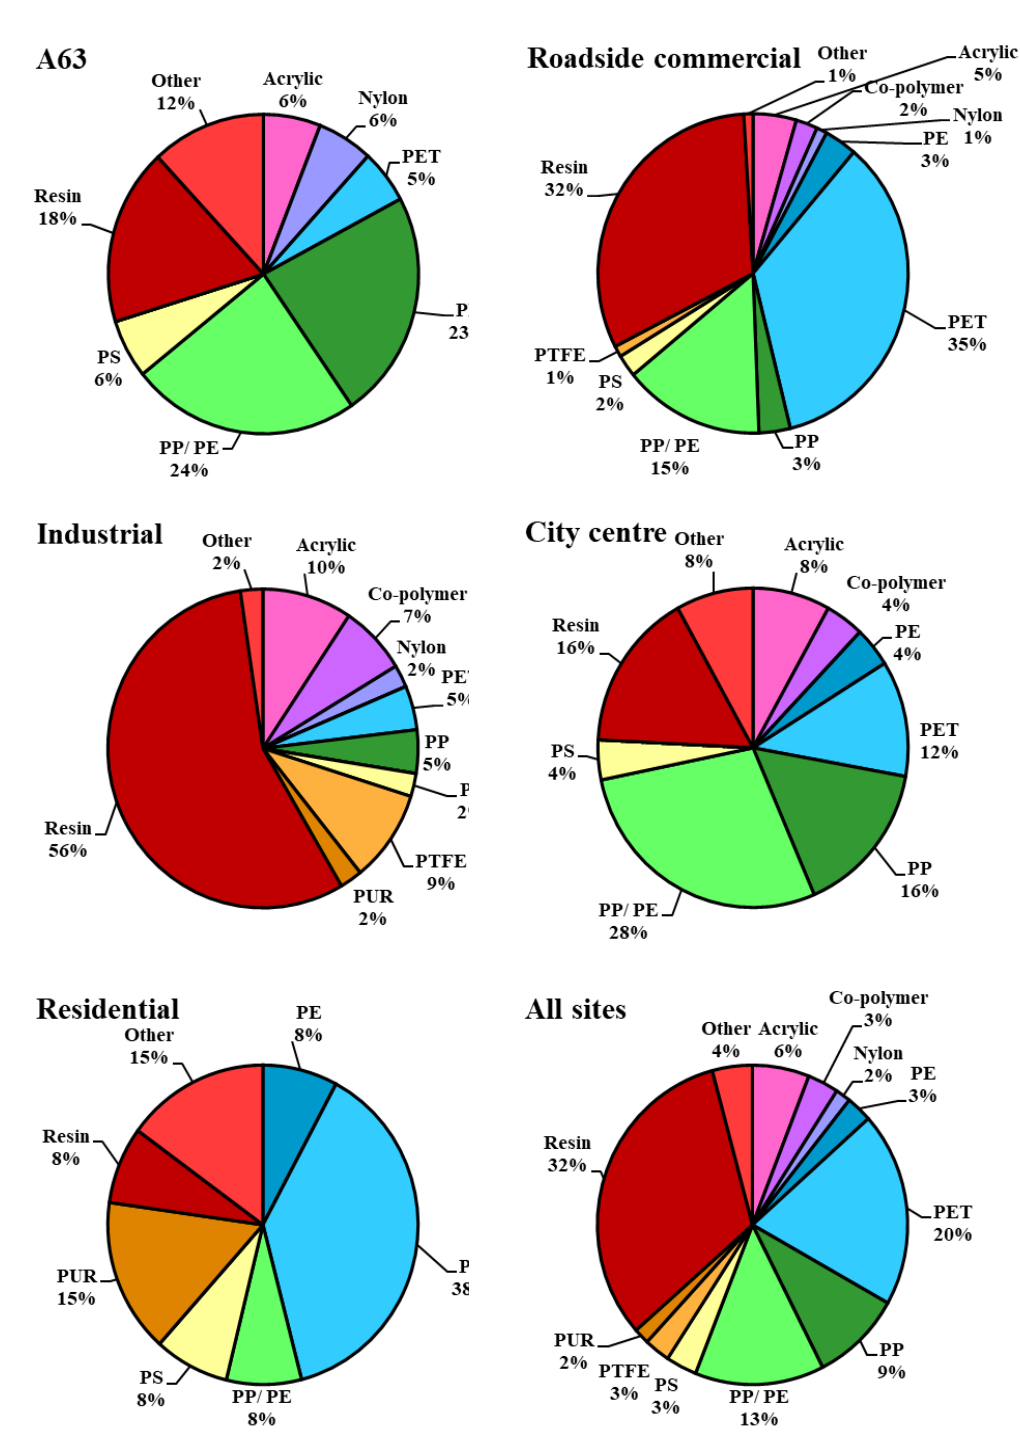
Figure 6. The proportion of MP polymer types within each sample at every site, during a single 2-week sampling period. A63 (Site 1), roadside commercial (Site 2), industrial (Site 3), city centre (Site 4), and residential (Site 5), and the overall proportion across “all sites” combined. Abbrevi- ations: EVA, ethylene vinyl acetate; PE, polyethylene; PET, polyethylene terephthalate; PMMA, polymethylmethacrylate; PP, polypropylene; PP/PE, polypropylene-polyethylene co-polymer; PS, polystyrene; PTFE, polytetrafluoroethylene; PUR, polyurethane; resin, including alkyd, hydrocarbon, and phenoxy